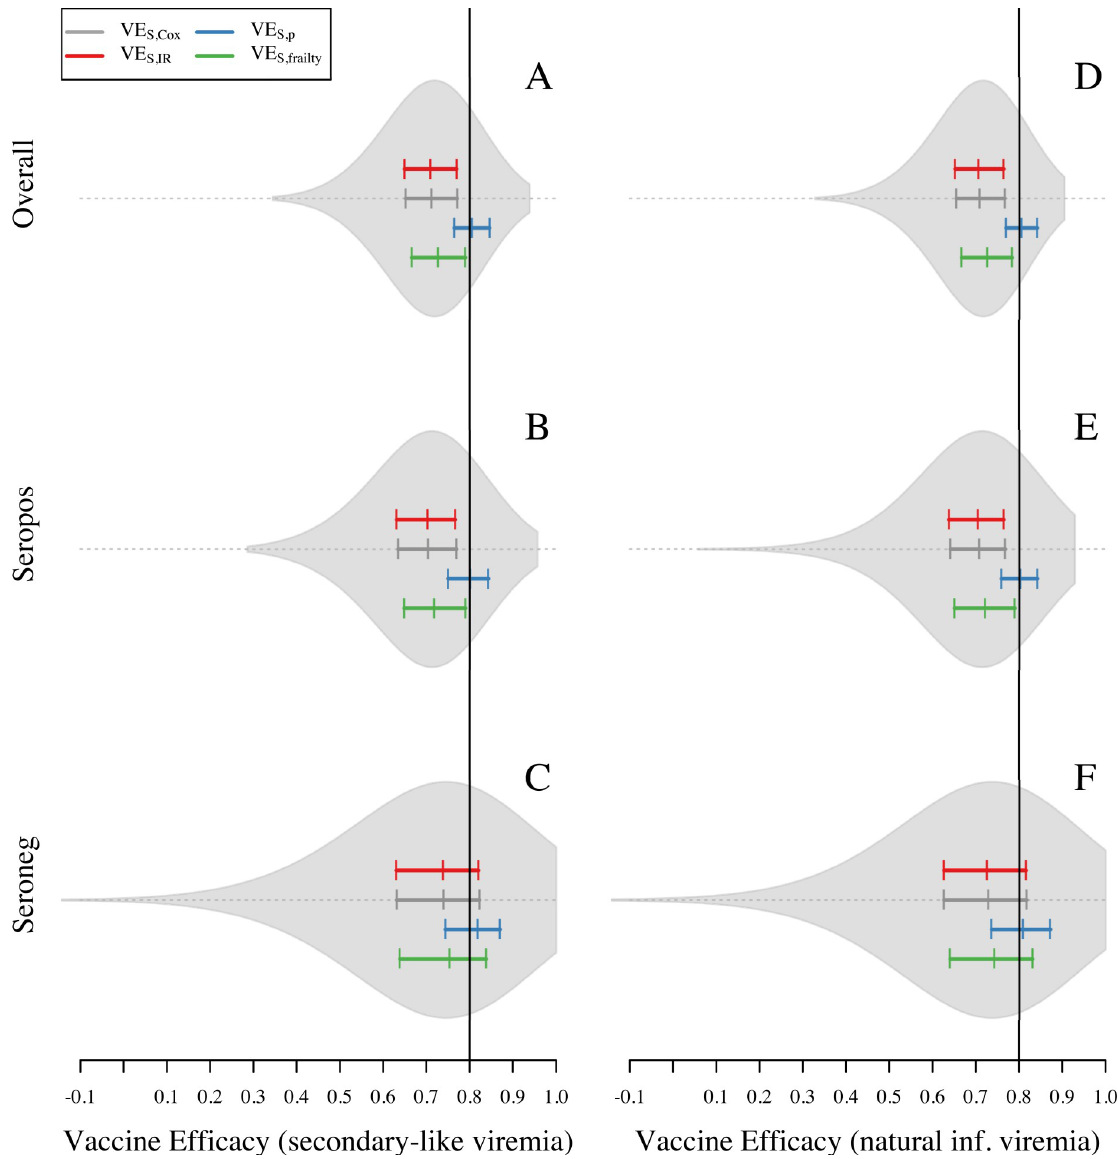
Fig 3. Overall VE S and VE S with stratification estimated for 1,000 simulations of the baseline scenario for one site. In this scenario, attractiveness of humans is proportional to their body size. VE S is calculated with four different methods: VE S,Cox , VE S,IR , VE S,CI , and VE S,p . Violin plots on the left panel show the shape of the distribution of VE S,Cox estimates. Colored solid lines show the 25, 50, and 75 quantiles for VE S,Cox , VE S,p , VE S,IR , and VE S,frailty (gray, blue, red, and green, respectively). Black solid line represents the true PEP = 1—RR inf|exp RR dis|inf = 0.8. Left panel corresponds to the assumption of viremia in vaccinated individuals as secondary infections. Right panel corresponds to the assumption of viremia in vaccinated individuals as a natural infection.